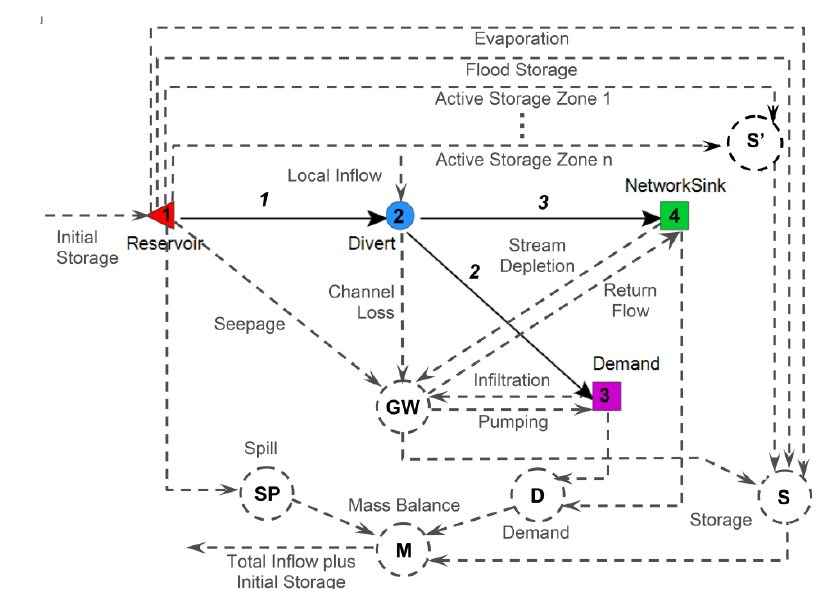
Figure 1. Illustration of MODSIM network structure with artificial nodes and links Application of Analytical Hierarchy Process